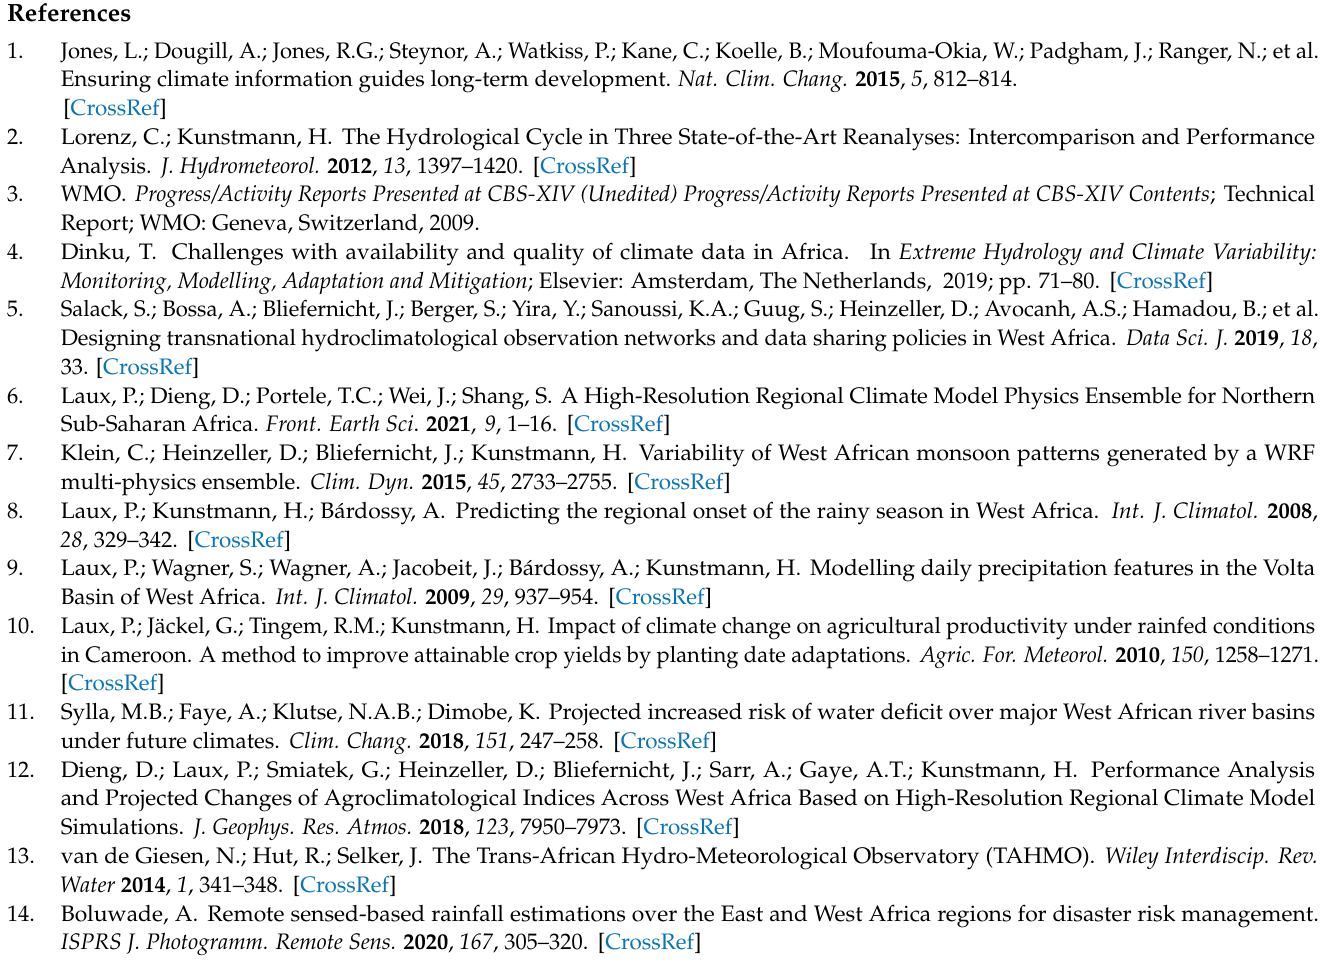
Figure A3. Number of missing values (MVs) [%] for all variables measured by the MET stations in Burkina Faso within the period